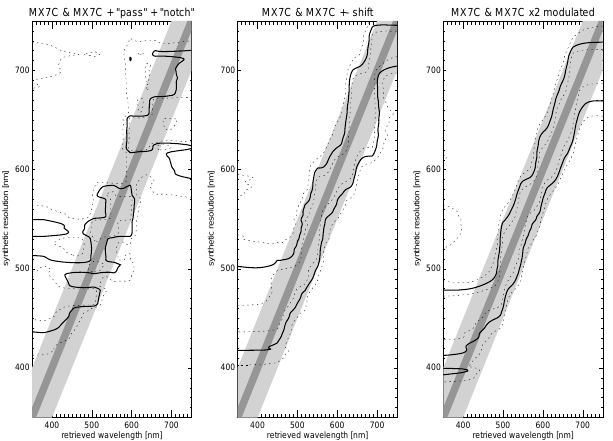
Figure 19. Backus–Gilbert spectral response analysis for combinations of three-color CCDs and filters: (a) two different notch filters, (b) two wavelength shifts of 1λ = ± 9nm, and (c) two sinusoidal modulations.